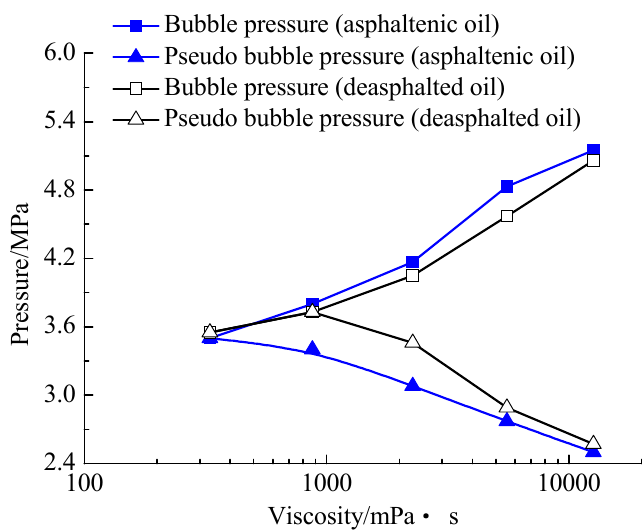
Figure 7. Effect of oil viscosity and asphaltene on bubble pressure and pseudo-bubble pressure.